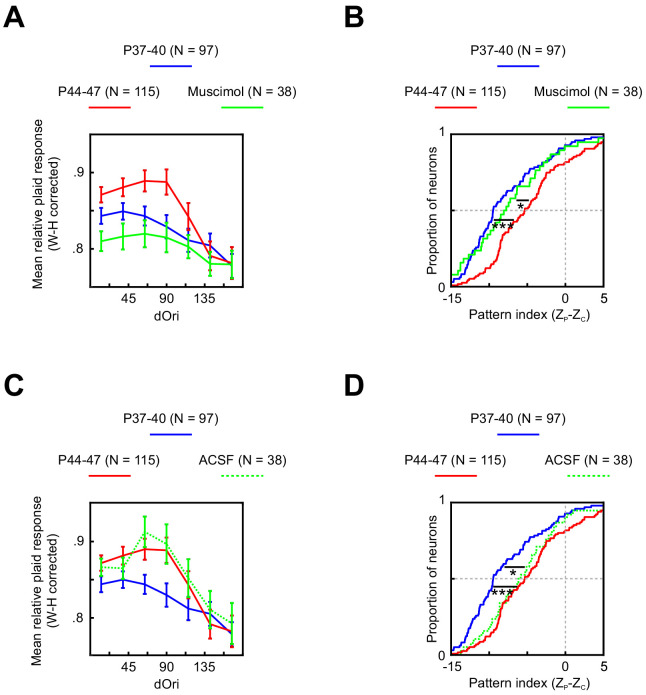
Changes in V1 responses at P44–47 depend on feedback from PSS.(A) Average relative plaid response in V1 at P37–40 (same data as Figure 5B), P44–47 (same data as Figure 5B), and P44–47 with muscimol inactivation of PSS. Error bars indicate ± SEM. Data are shown after a Wilson–Hilferty transformation. For statistical analysis of data across age groups, see Table 1. (B) Cumulative distribution of V1 pattern indices at P37–40 (same data as Figure 5D), P44–47 (same data as Figure 5D), and P44–47 with muscimol inactivation of PSS. For statistical analysis of data across age groups, see Table 1. *p<0.05. ***p<0.001. (C, D) Same plots as (A, B) but after a control injection of ACSF into PSS. Note that the ACSF group included one animal aged P48, making the age range for this group P44–48.Figure 6—source data 1.Neuron-by-neuron metrics for Figure 6.